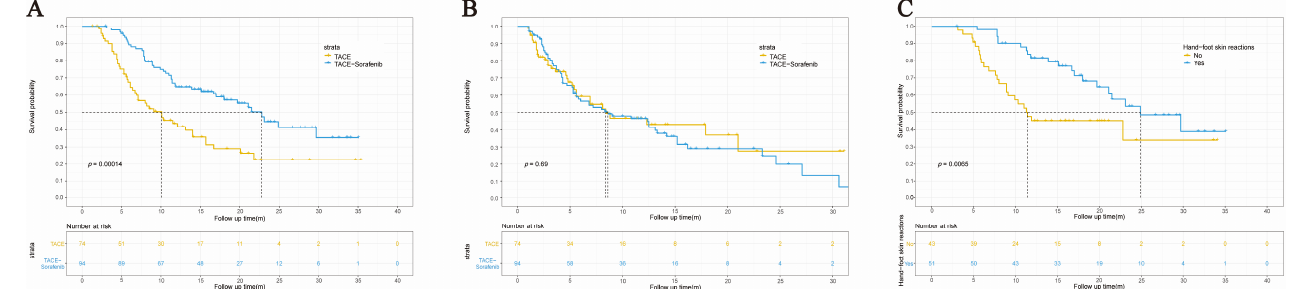
Figure 2. Kaplan–Meier survival curves of unresectable HCC patients. ( A ) Kaplan–Meier overall survival (OS) curves for two cohorts. ( B ) Kaplan–Meier progression-free survival (PFS) curves for two cohorts. ( C ) Kaplan–Meier OS curves for patients with or without hand-foot skin reactions in the TACE–sorafenib cohort.